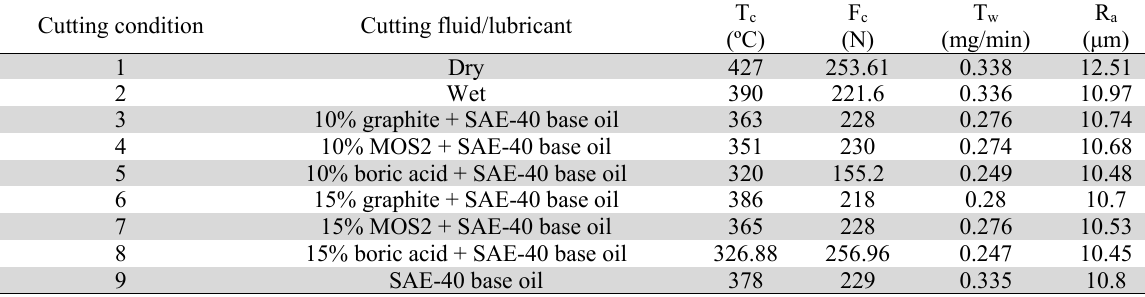
Decision matrix for case study 2 (Abhang & Hameedullah 2012) Cutting condition Cutting fluid/lubricant